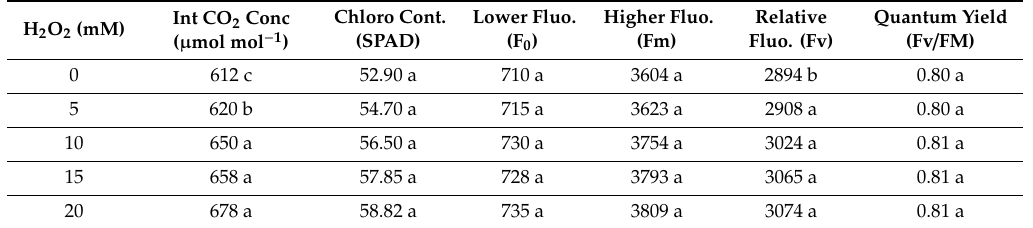
Table 2. The e ff ects of H 2 O 2 treatment on physiological properties of Ficus deltoidea plant. Means within the di ff erent line followed by the same letter, do not di ff er significantly according to Tukey HSD test at α = 0.05.